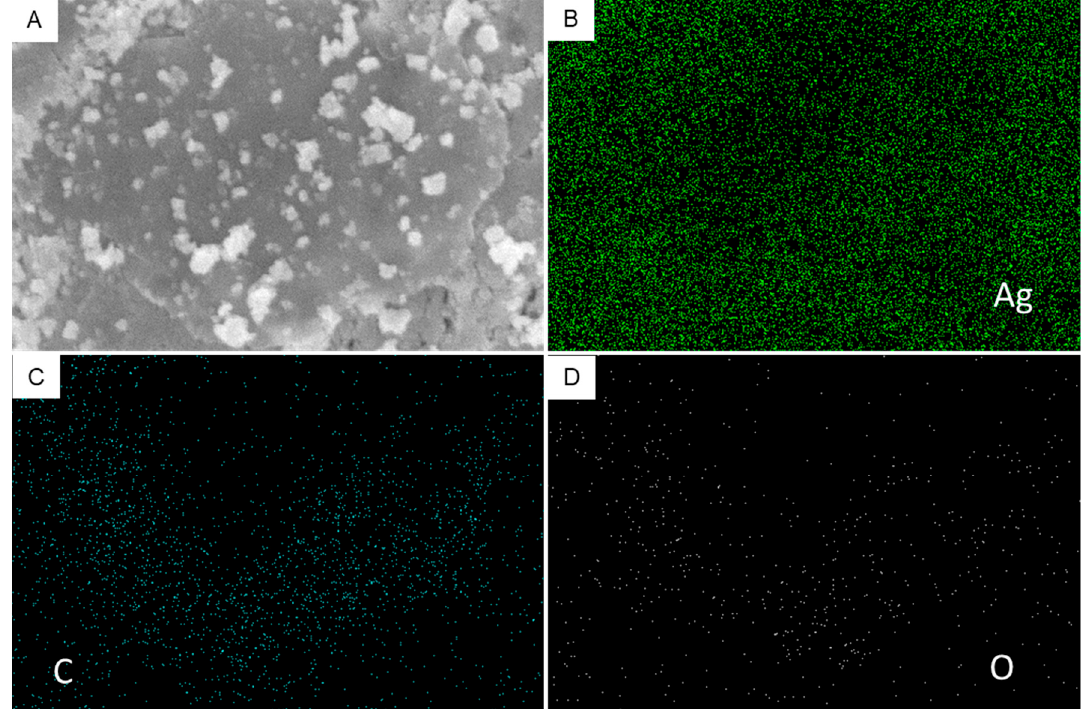
Figure 7. SEM elemental mapping of Ag/RGO NCs: ( A ) SEM micrograph; ( B ) Ag mapping; ( C ) C mapping; ( D ) O map- ping.